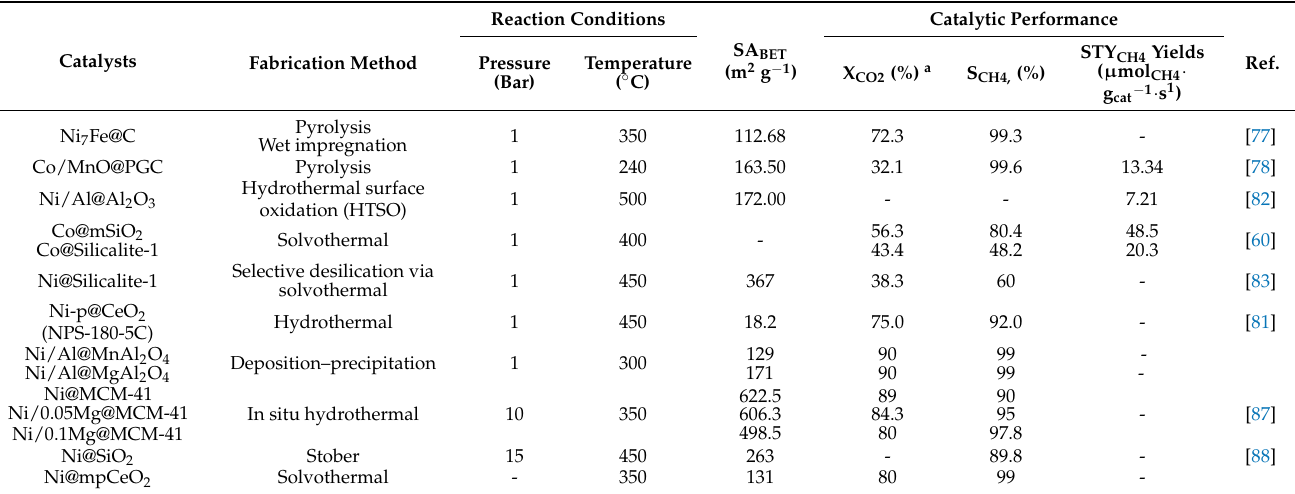
Table 1. Catalytic performance of core-shell catalysts in CO 2 hydrogenation to